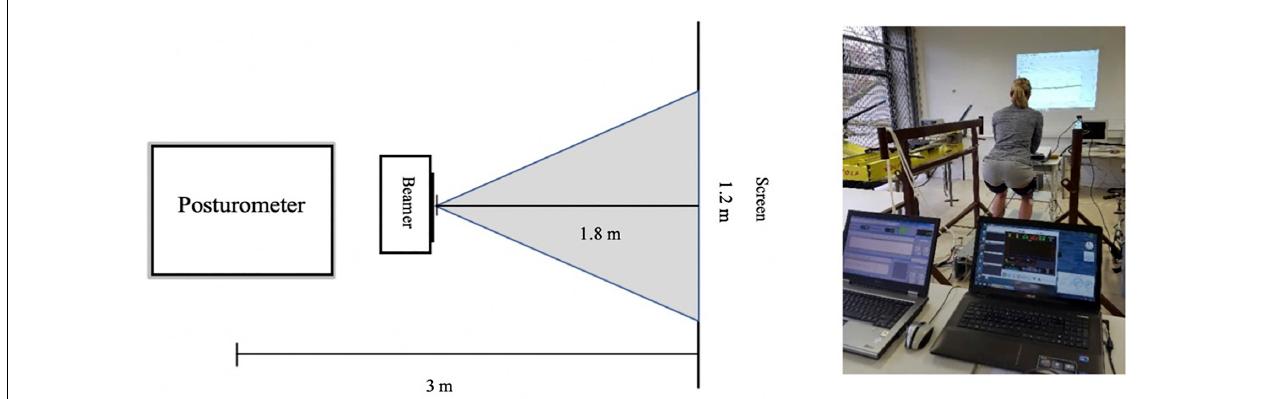
FIGURE 2 | Test setup. Left: bird’s-eye view of the setup. Right: setup in the BFR condition.